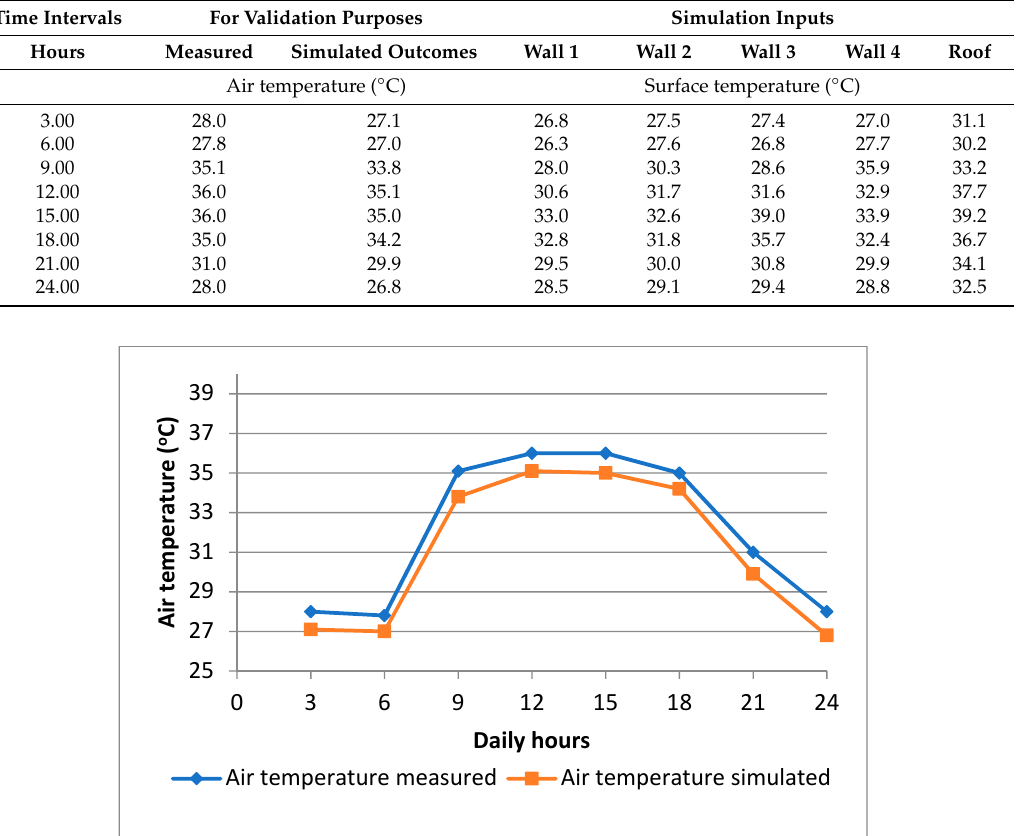
Figure 8. Actual measured air temperature under the shaded roof against CFD simulation output at pedestrian level for validation purposes.